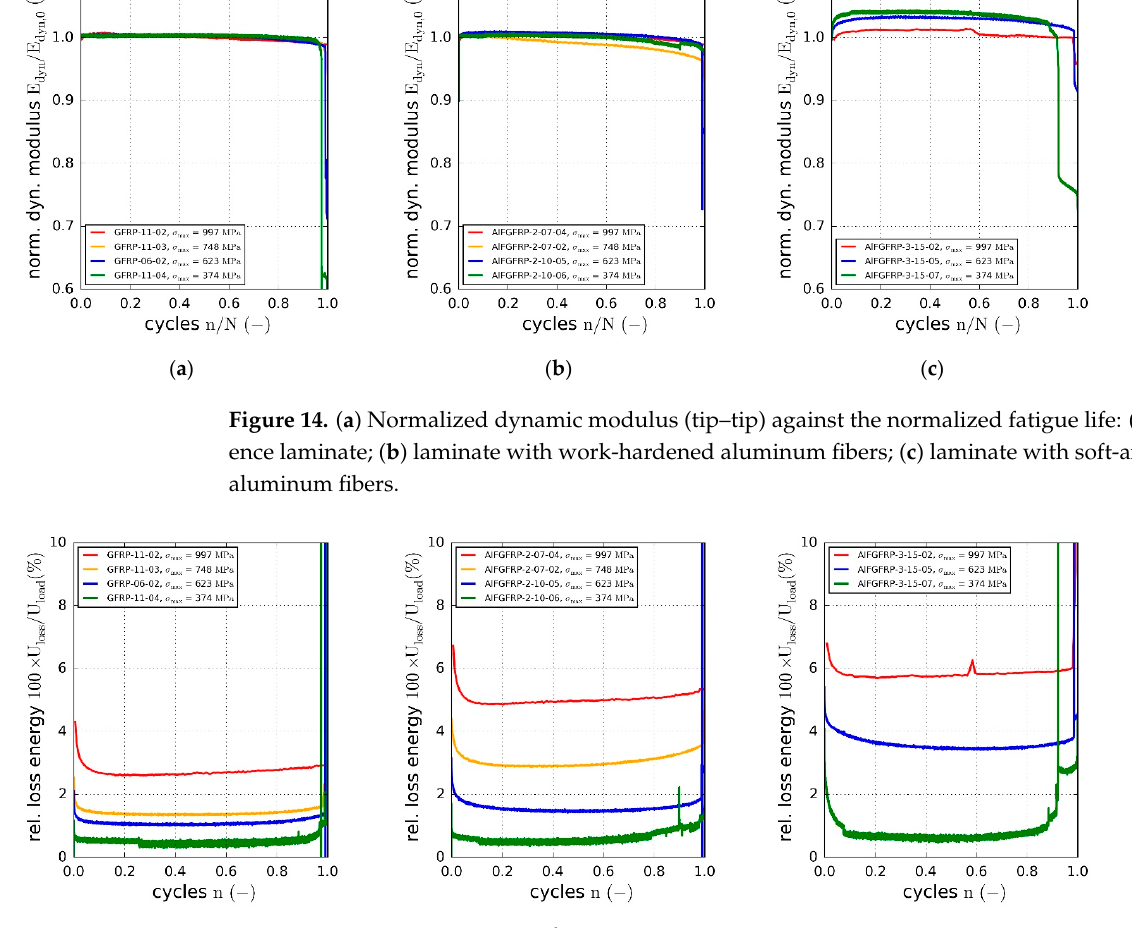
Figure 14. ( a ) Normalized dynamic modulus (tip–tip) against the normalized fatigue life: ( a ) refer- ence laminate; ( b ) laminate with work-hardened aluminum fibers; ( c ) laminate with soft-annealed aluminum fibers.